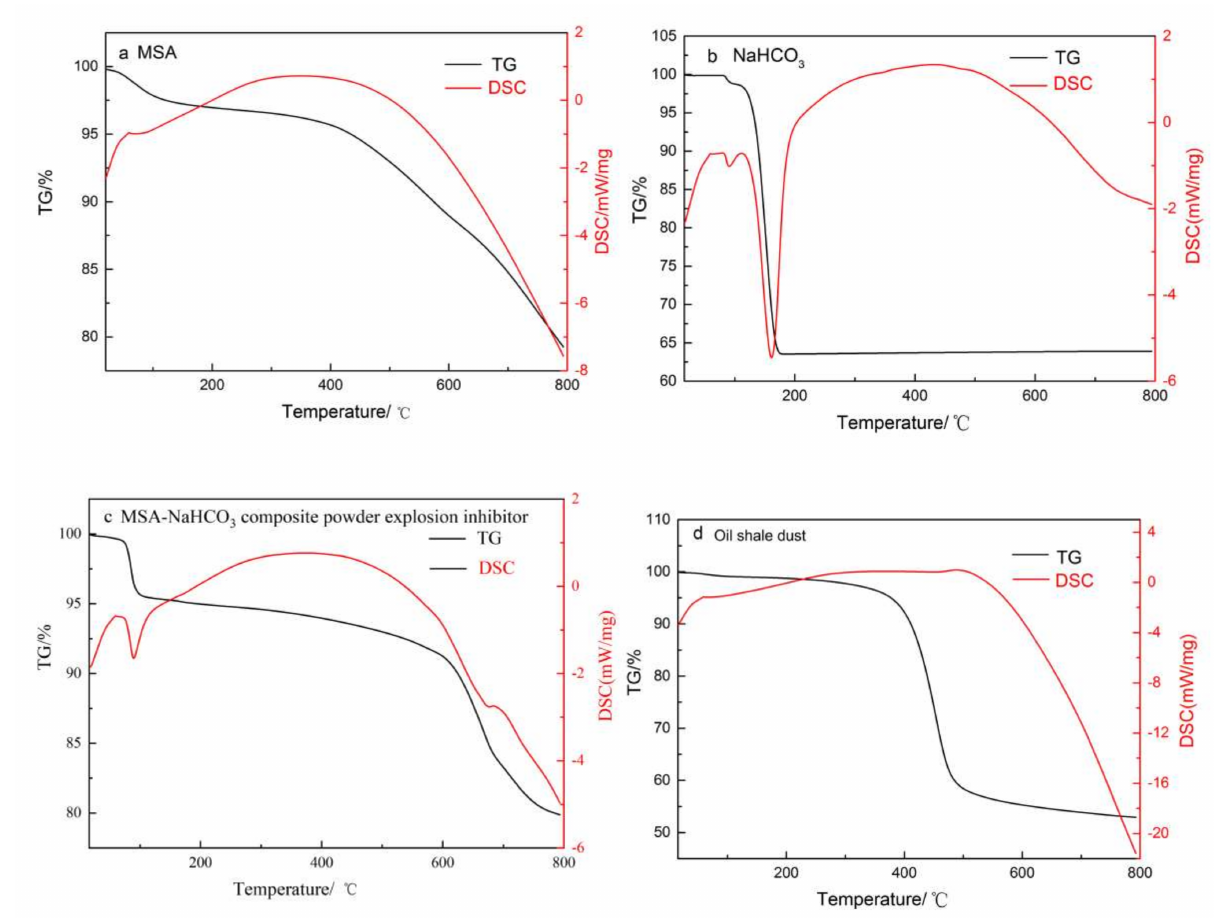
Figure 14. The TG-DSC curves of the target dust. ( a ) the TG–DSC curve of MSA; ( b ) the TG–DSC curve of NaHCO3; ( c ) the TG-DSC curve of the MSA–NaHCO3; ( d ) the TG-DSC curve of the oil shale